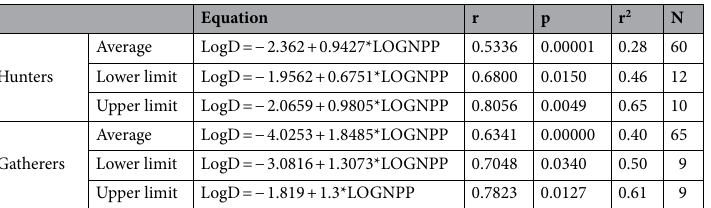
Table 1. Simple linear regression of log-transformed hunter-gatherer population density (D) on log- transformed net primary productivity (LOGNPP). Regression equations were fitted to the whole sample (average) and the upper and lower limit of the distribution for each procurement strategy.